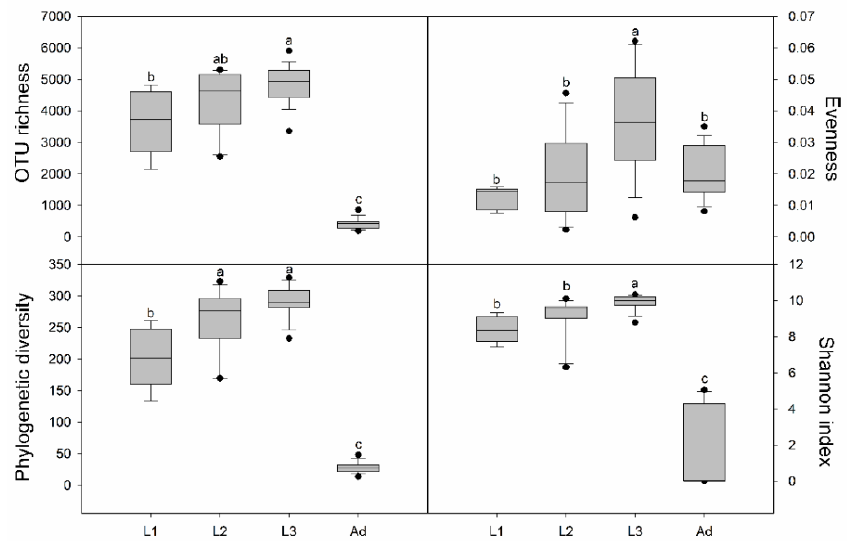
Figure 2. Intestinal bacterial alpha-diversity in different developmental stages. The bottom and top of the box denote the first and third quartiles respectively; the band inside the box denotes median; error bars denote standard deviations; different letters above bars represent significant differences from Tukey’s HSD comparisons ( p < 0.05). L1, 1st instar; L2, 2nd instar; L3, 3rd instar; Ad, Adults.